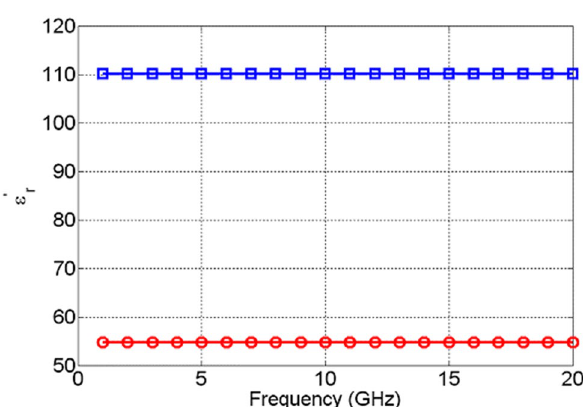
′ Figure 15. Extracted ε r of TiO 2 OFF state (red circles) and ON state (blue